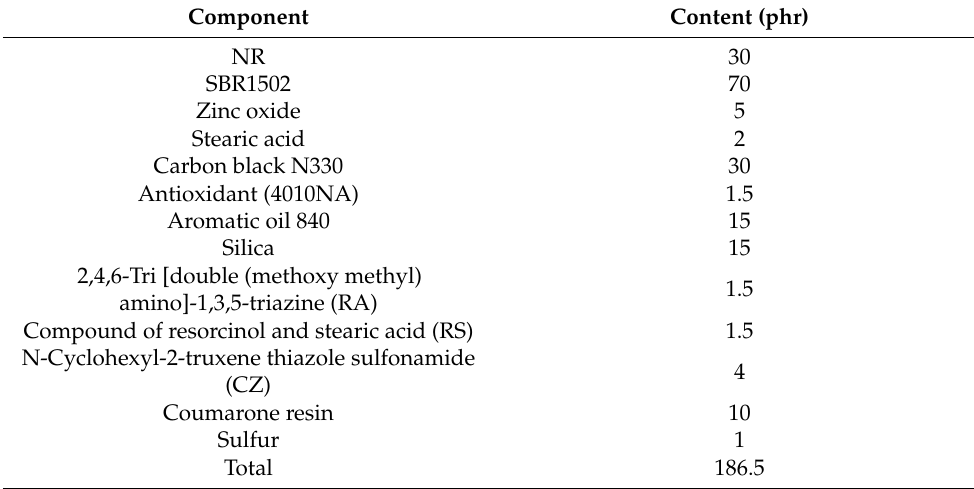
Figure 2. Preparation process of fabric rubber composites. Table 1. The rubber compound